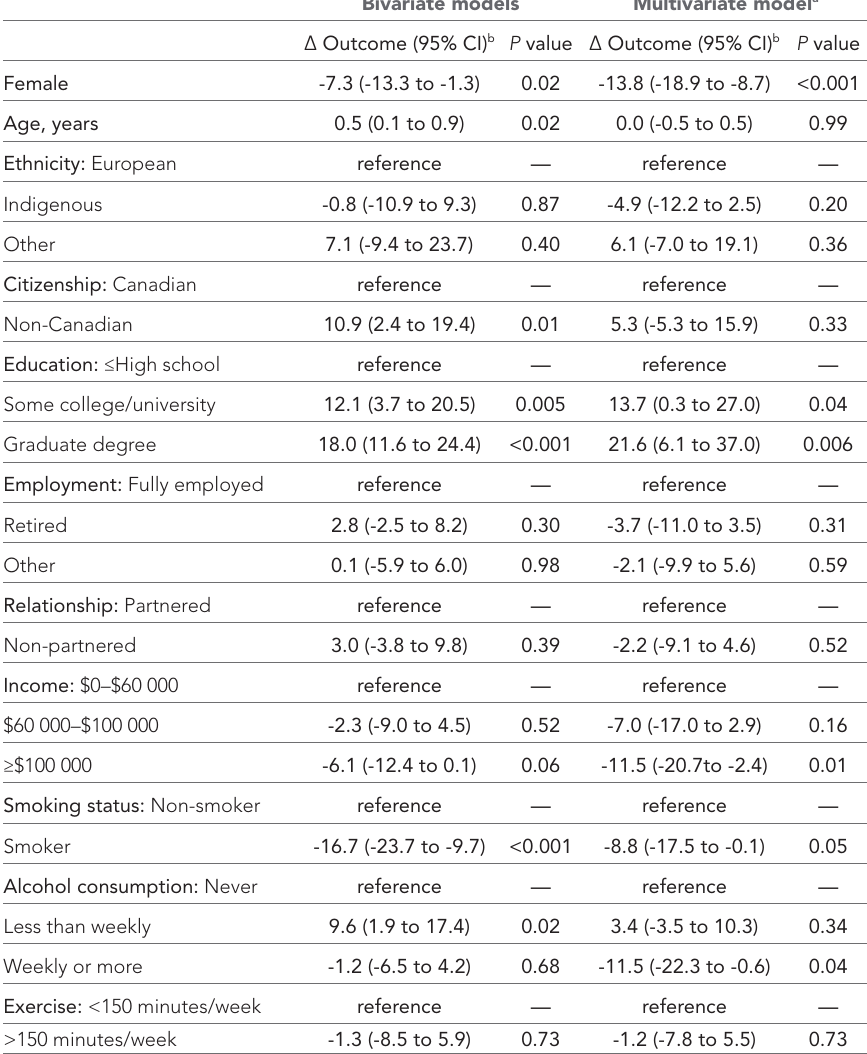
Table 4 Demographic and clinical characteristics associated with differences in composite outcome score Bivariate models Multivariate model